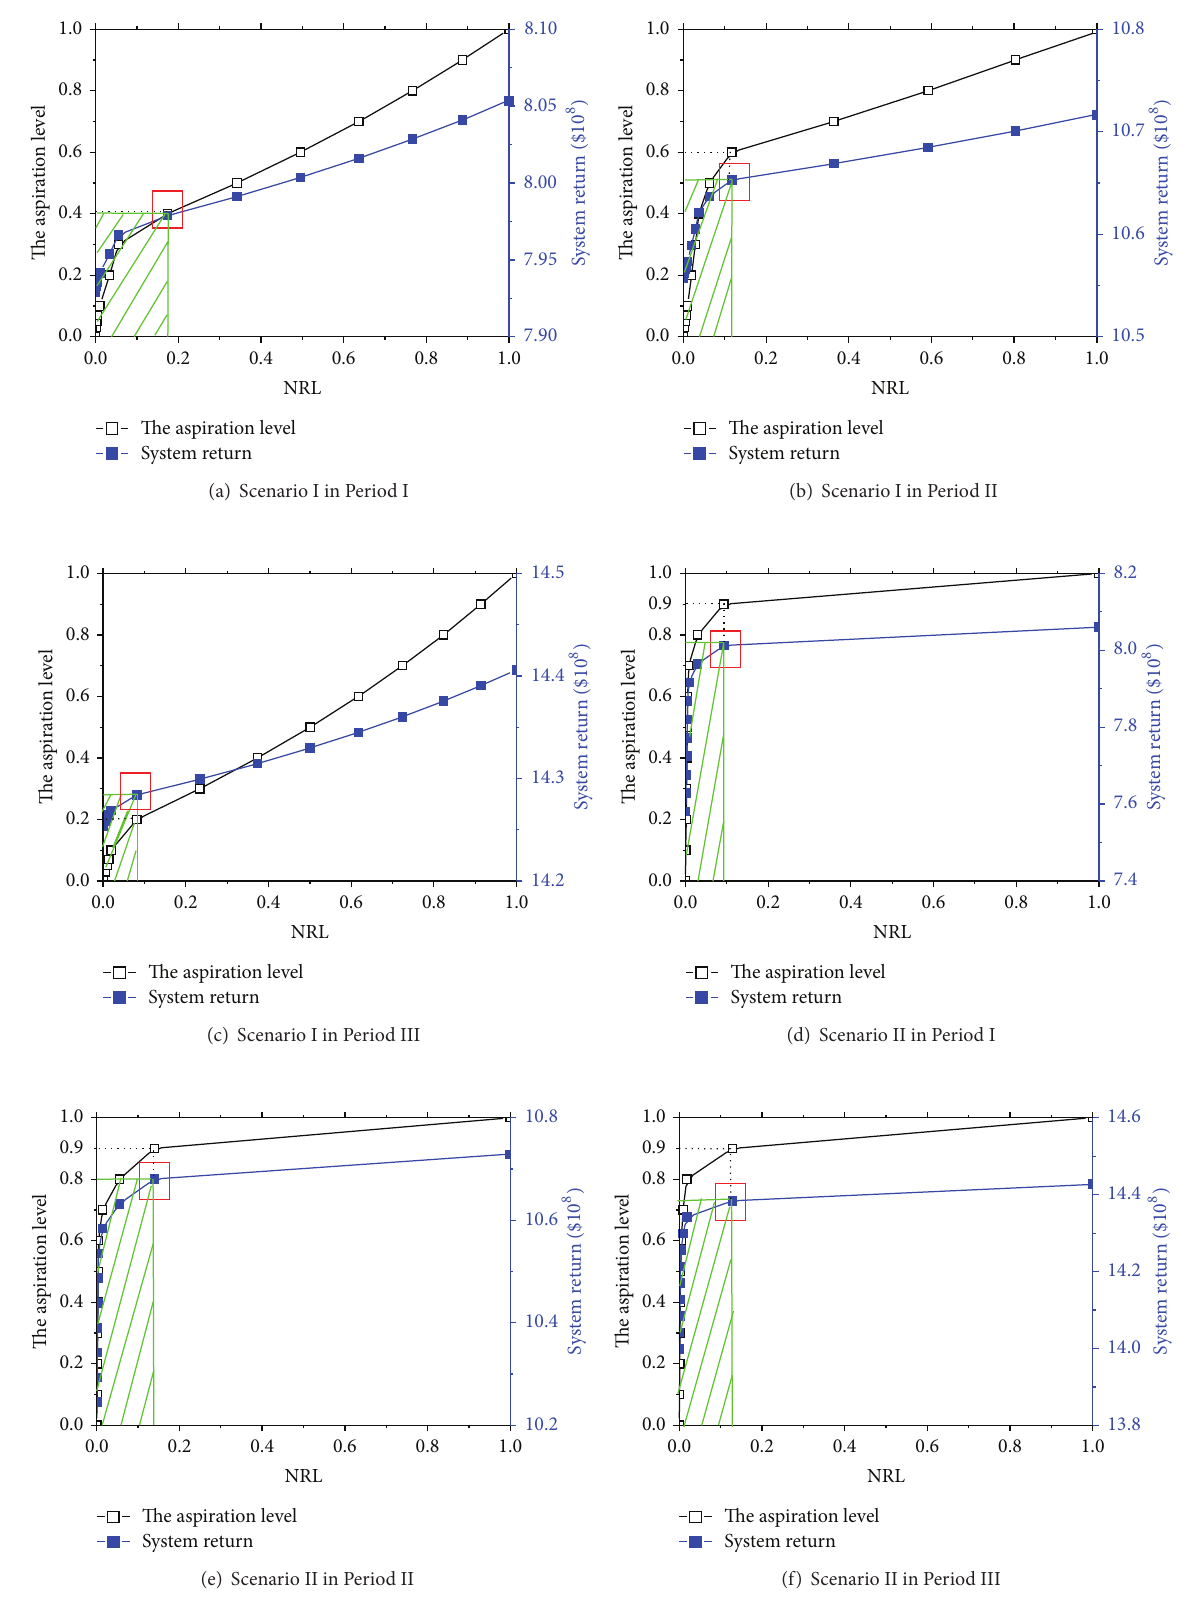
Figure 3: Trade-off curve for three planning periods under two